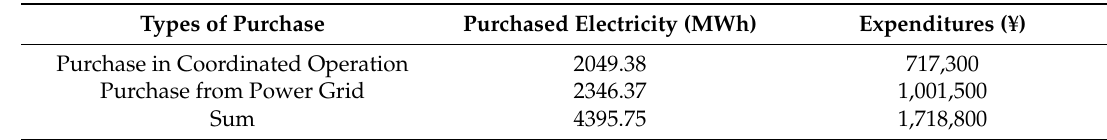
Table 7. Power purchase of LA after coordinated operation.